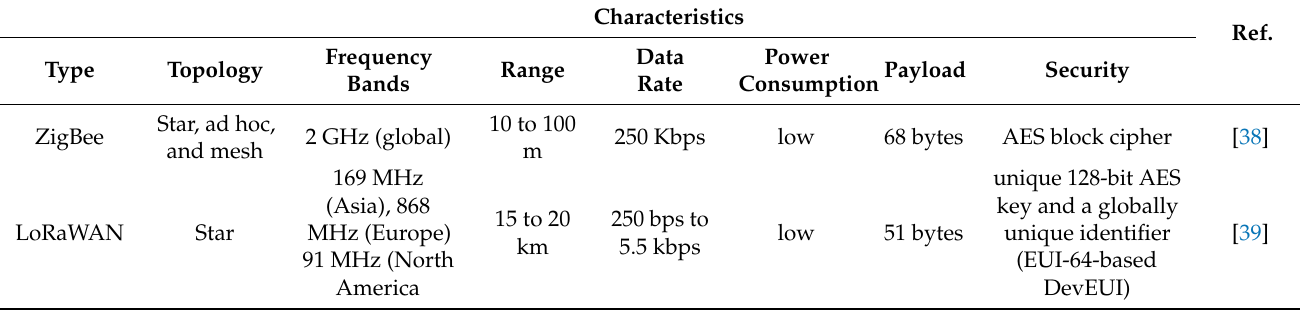
Table 2. Wireless technologies comparison for wearable communication. Characteristics